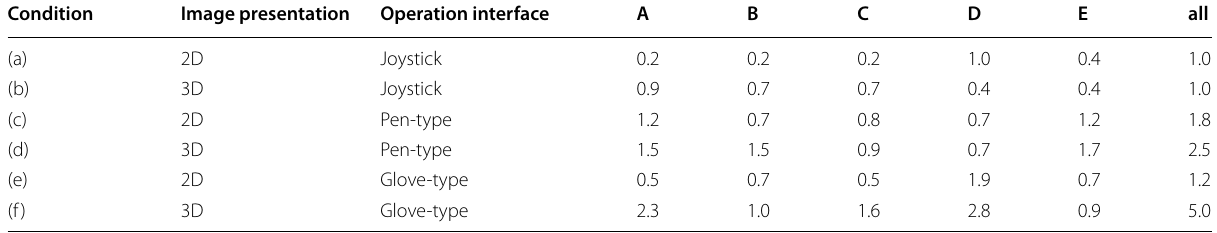
Condition Image